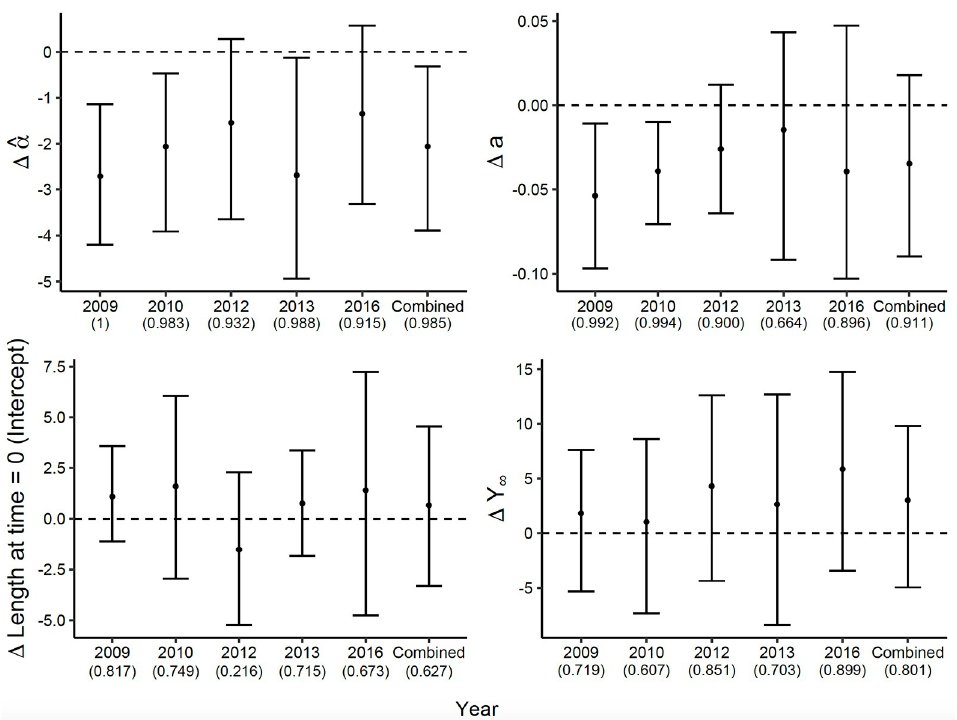
Fig 5. The difference ( Δ ; recaptures − others) in estimates of all model parameters ± the 95% credible interval between the two capture types of young-of-the-year Chinook salmon. Recaptures in restored habitat; others = fish marked and not recaptured, regardless of capture origin. Year-specific estimates incorporate the random effect of year, and combined differences are based on the average parameter values among years. The number in parentheses represents the fraction of posterior draws for which the difference was above or below zero, as appropriate. Δ Length at time = 0 was substituted for model parameter Y 0